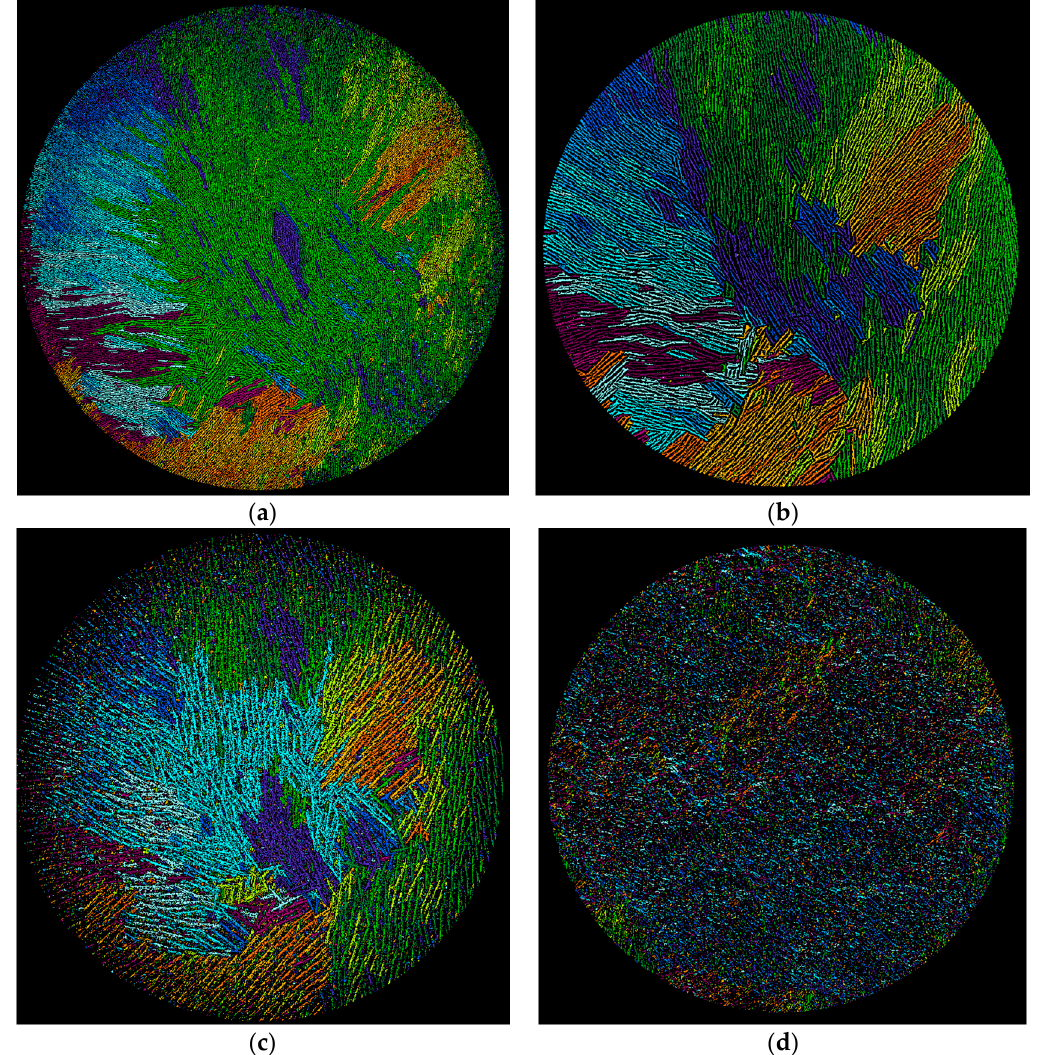
Figure 6. Image-analyzed X-ray micro-computed tomographs of images in Figure 5a–d to reveal orientation of domains at different heights, h, within monolith, h (cf. Figures 1a and 5). ( a ) φ v = 0.128, h = 0.90, pores image; ( b ) φ v = 0.128, h = 0.5, lamellae image; ( c ) φ v = 0.128, h = 0.18, pores image; ( d ) φ v = 0.032, h = 0.9, lamellae image.